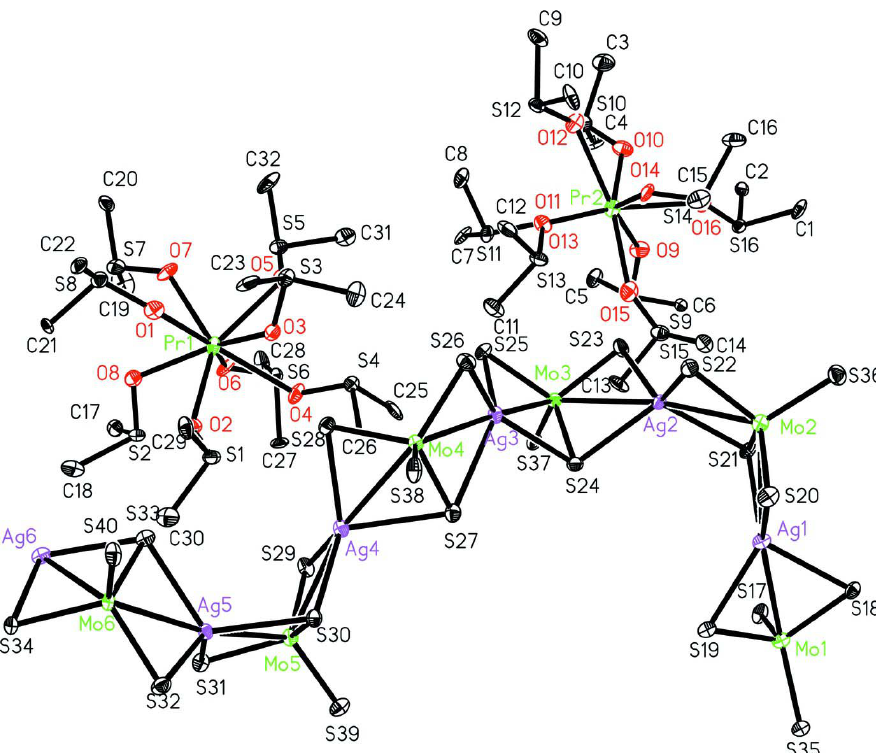
Figure 1 The molecular structure of (I), with atom labels and 30% probability displacement ellipsoids. All H atoms have been